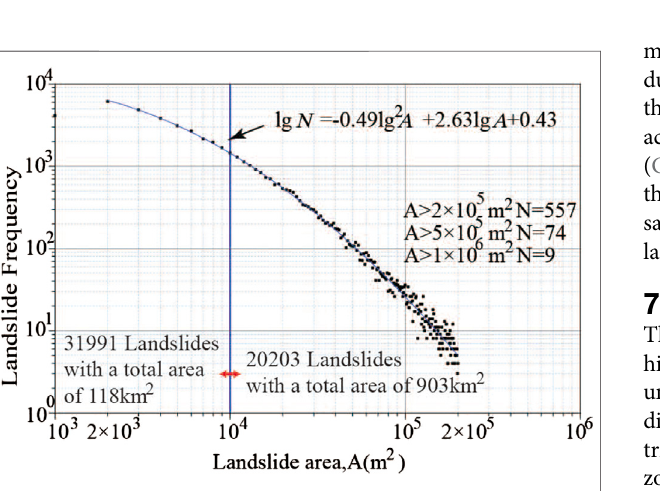
Frontiers in Earth Science |